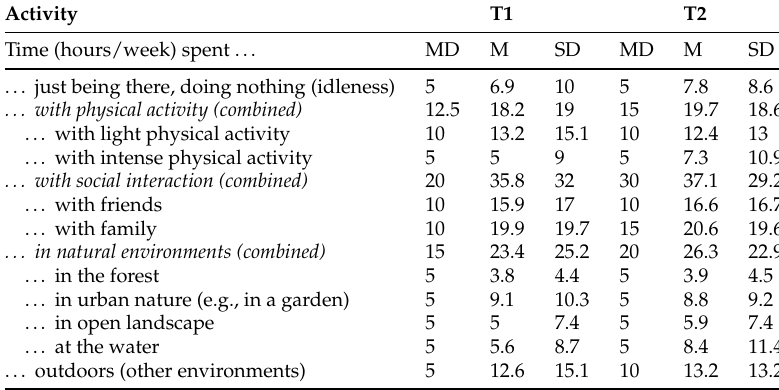
Table 2. Time spent with recreational activities and in natural environments. None of the differences between T1 and T2 were statistically significant. Activity Time (hours/week) spent ...